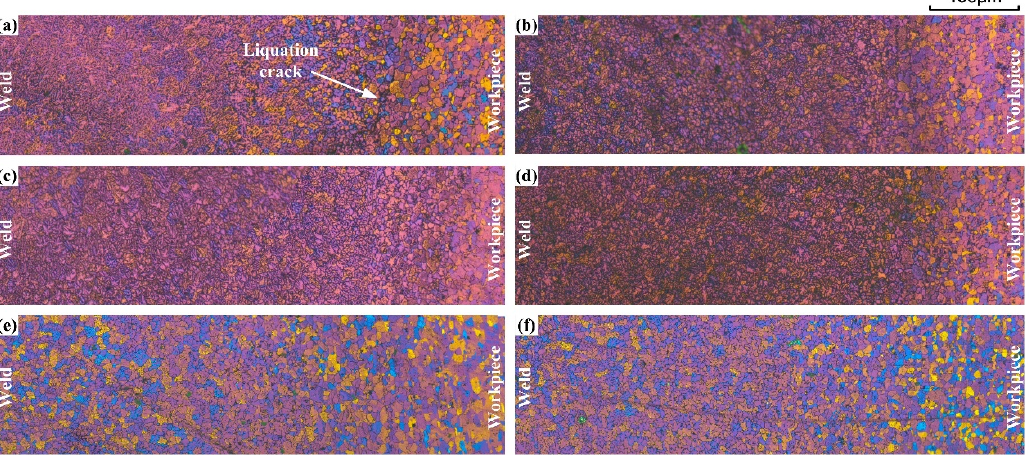
Figure 7. Colur metallography images of different joints (butt-welding): ( a ) The AA7075/ER5356 joint; ( b ) AA7075/Al-Cu 1.5 -Si 4.5 joint; ( c ) the AA7075/Al-Cu 3.0 -Si 2.5 joint; ( d ) the AA7075/Al-Cu 4.5 -Si 1.5